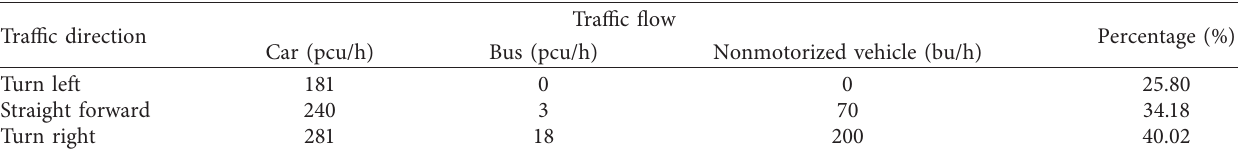
Table 2: Traffic flow survey data for Tieji